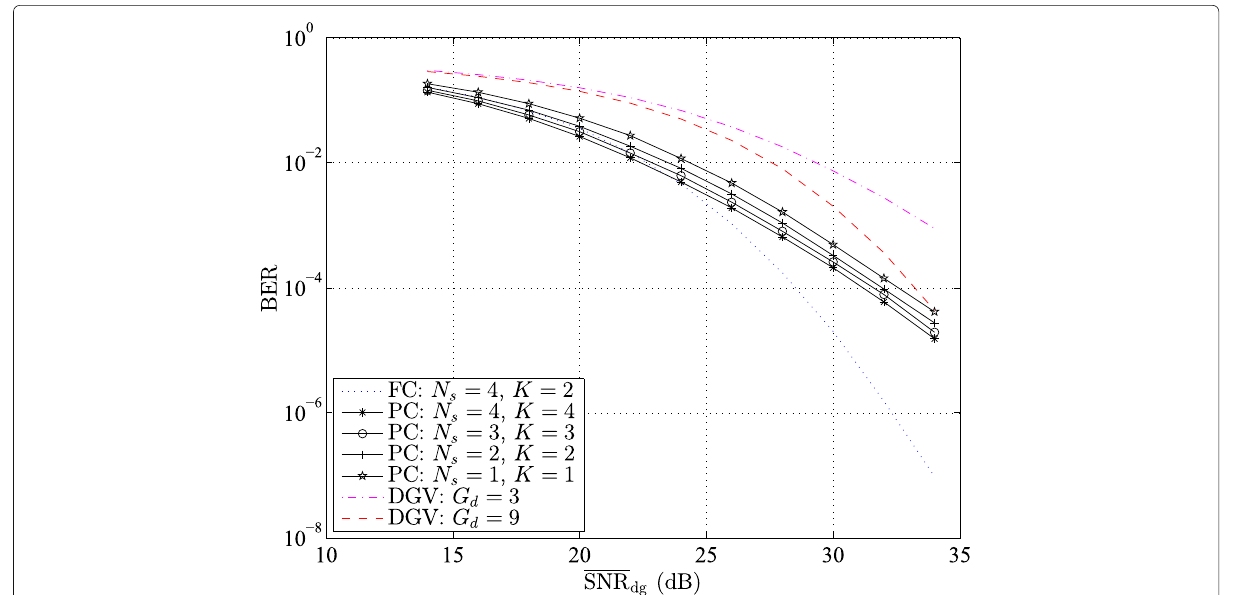
Fig. 7 BER versus designed SNR: comparion between the the proposed distributed subarray architecture and the conventional partially connected